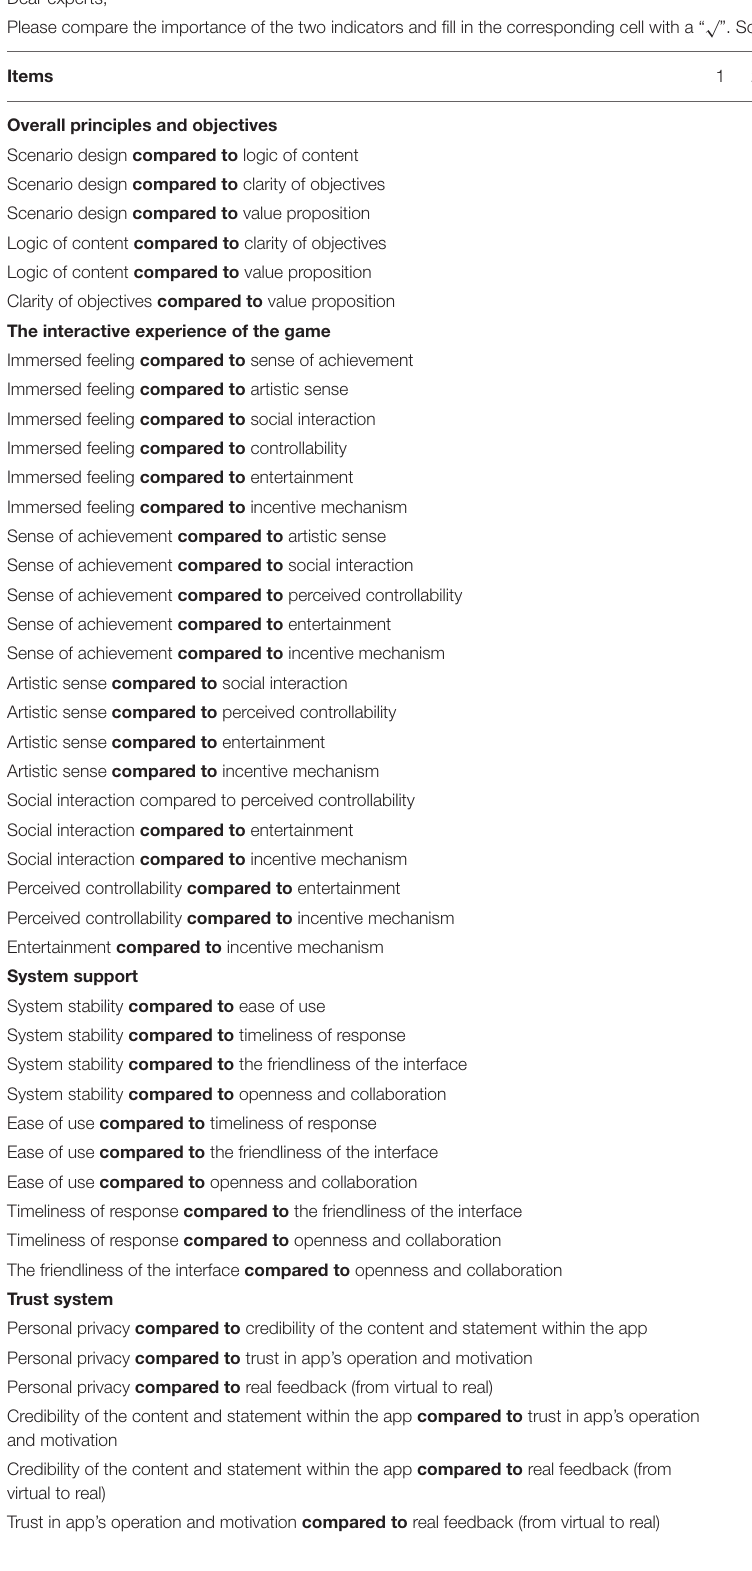
TABLE 4 | Questionnaire for the evaluation of sustainable consumption gamification applications. Dear